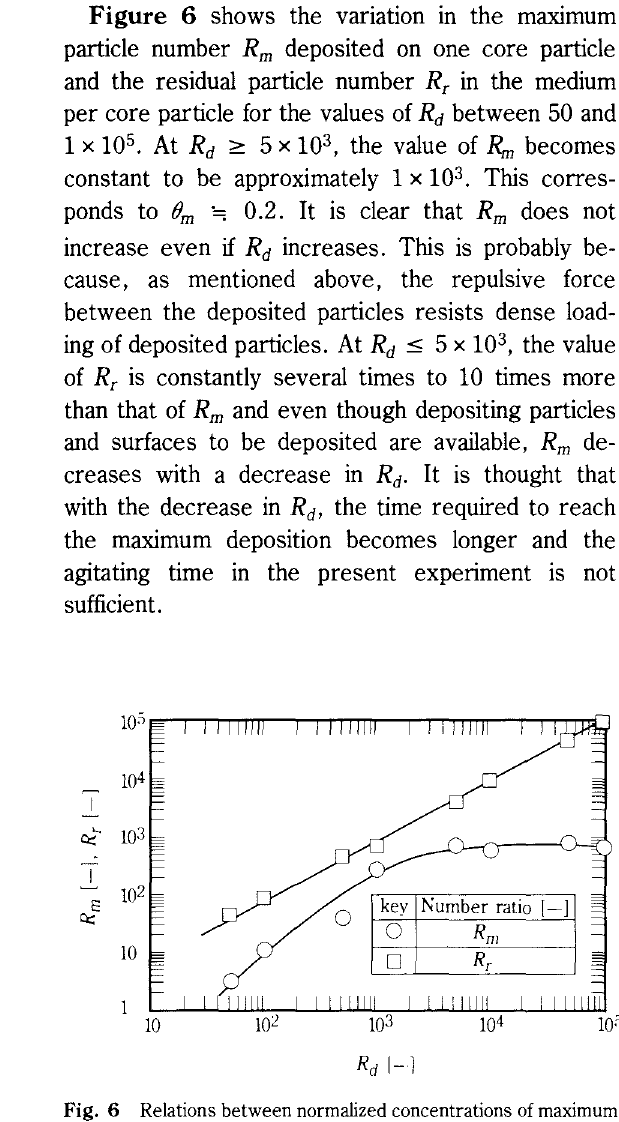
Fig. 6 Relations between normalized concentrations of maximum deposited particles (Rd), residual particles in the medium (Rr) and dosed depositing particles (Rd)